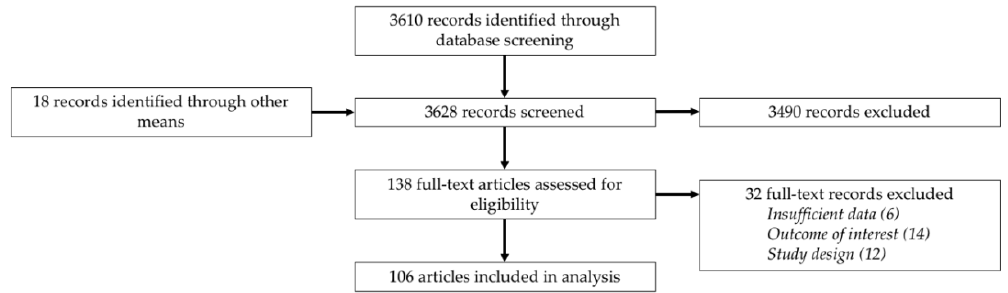
Figure 1. Preferred Reporting Items for Systematic Reviews and Meta-Analyses (PRISMA) study selection diagram.